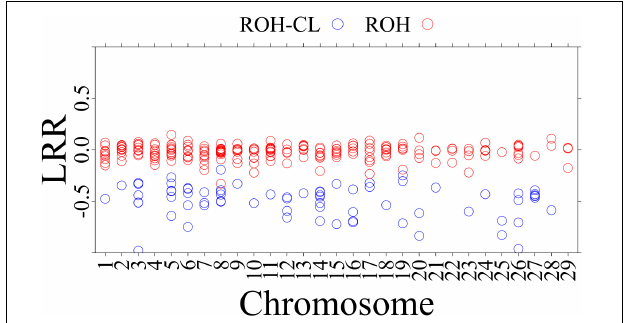
FIGURE 4 | Distribution of mean LRR values in the sampled ROH and in the ROH-CL. The red dots are for ROH while the blue dots are for ROH-CL intersections.